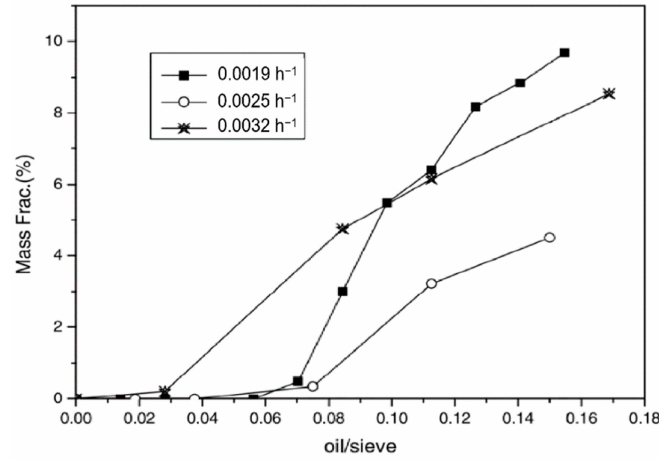
Figure 4. Relationship between oil/sieve ratio and n-paraffin mass fraction at different space velocities [35]. Oil/sieve ratio: raffinate oil/molecular